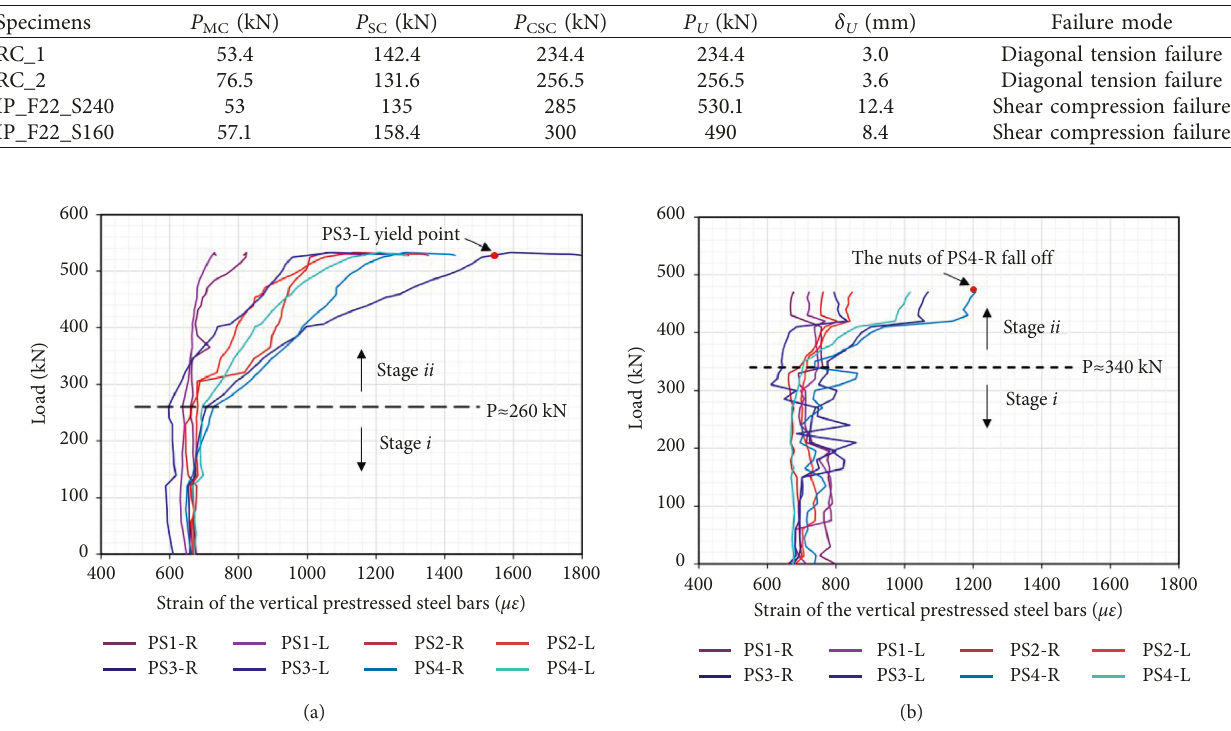
Figure 5: VPSBs stress–strain curve and cracking pattern at shear failure of specimens. (a) IP_F22_S240. (b)